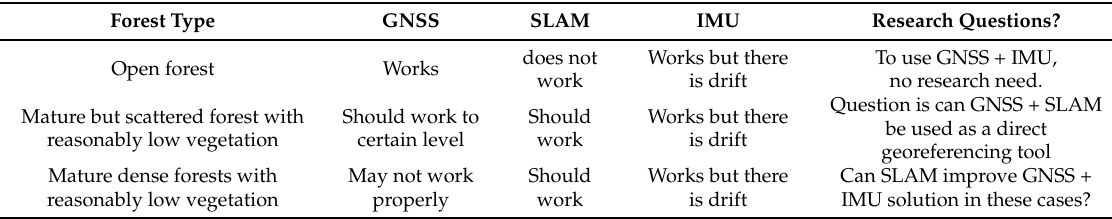
Table 1. Logic for different cases of positioning in